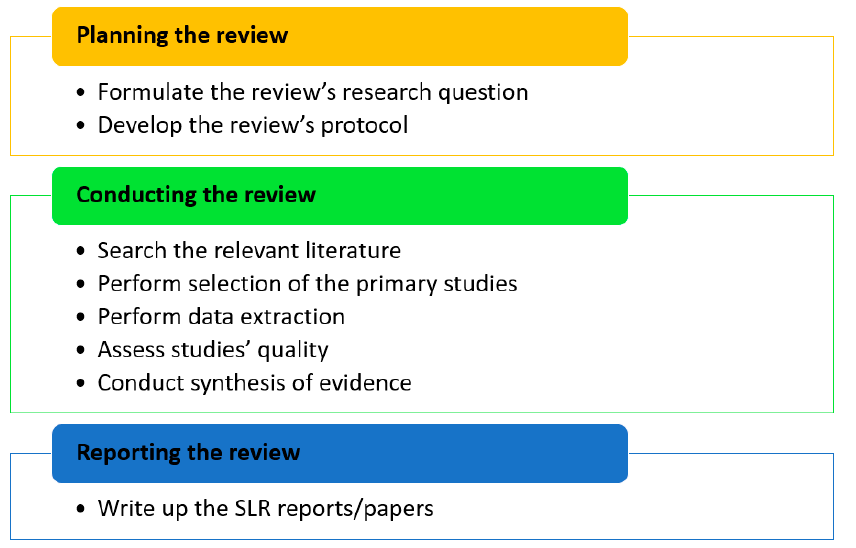
Figure 3. The systematic review phases. Table 1. The SLR research questions and their